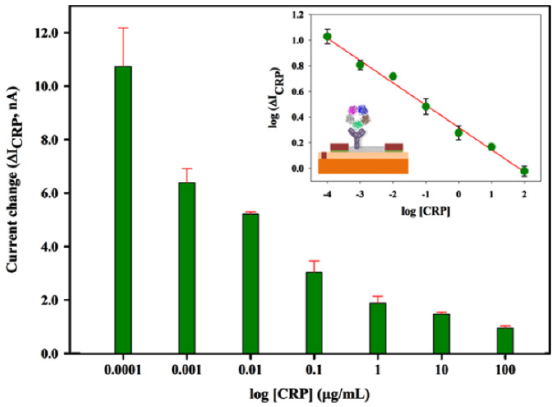
Reprinted from Talanta, 108, Justino et al., Disposable immunosensors for c-reactive protein based on